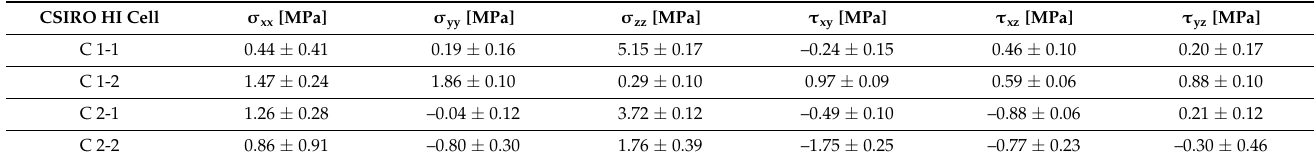
Table 5. Calculated in situ stress tensors